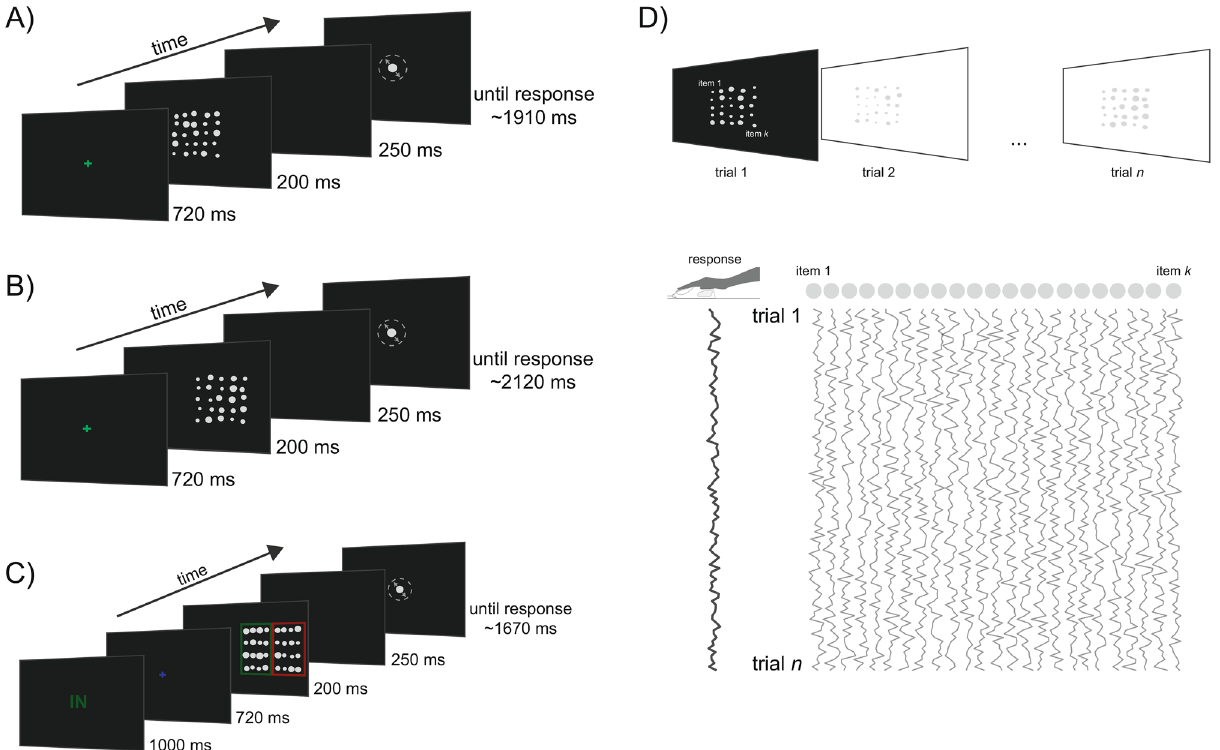
Figure 1. Sequence of events in the ensemble coding tasks. ( A ) Example of one trial in Experiment 1. Stimuli were presented at the fovea with different degrees of dispersion (see “General methods” section). After the fixation cross, an ensemble of 25 disks was presented for 200 ms, followed by a blank interval. The task was to adjust the size (diameter) of a single central disk so that it reproduced the average size of the set of stimuli in the ensemble. ( B ) Example of one trial in Experiment 2, with the ensemble presented on the right side of the display. In this experiment, ensembles could randomly appear on the left, in the center or on the right side. ( C ) Example trial in Experiment 3. At the beginning of each trial, participants received a visual cue (here ‘IN’) indicating the region of the screen where the relevant ensemble was presented (here the internal region). After a fixation interval, two ensembles separated by colored frames were presented. Participants had to reproduce the average size of stimuli inside the relevant ensemble, indicated by a frame that matched the color of the initial cue. ( D ) Derivation of spatial weighting maps (SWMs). Local variations in the size of each disk across trials were used as multivariate regressors explaining the trial sequence of adjustment responses. Two-dimensional SWM were obtained by estimating the weight (regression coefficient) of each disk at each location on participants’